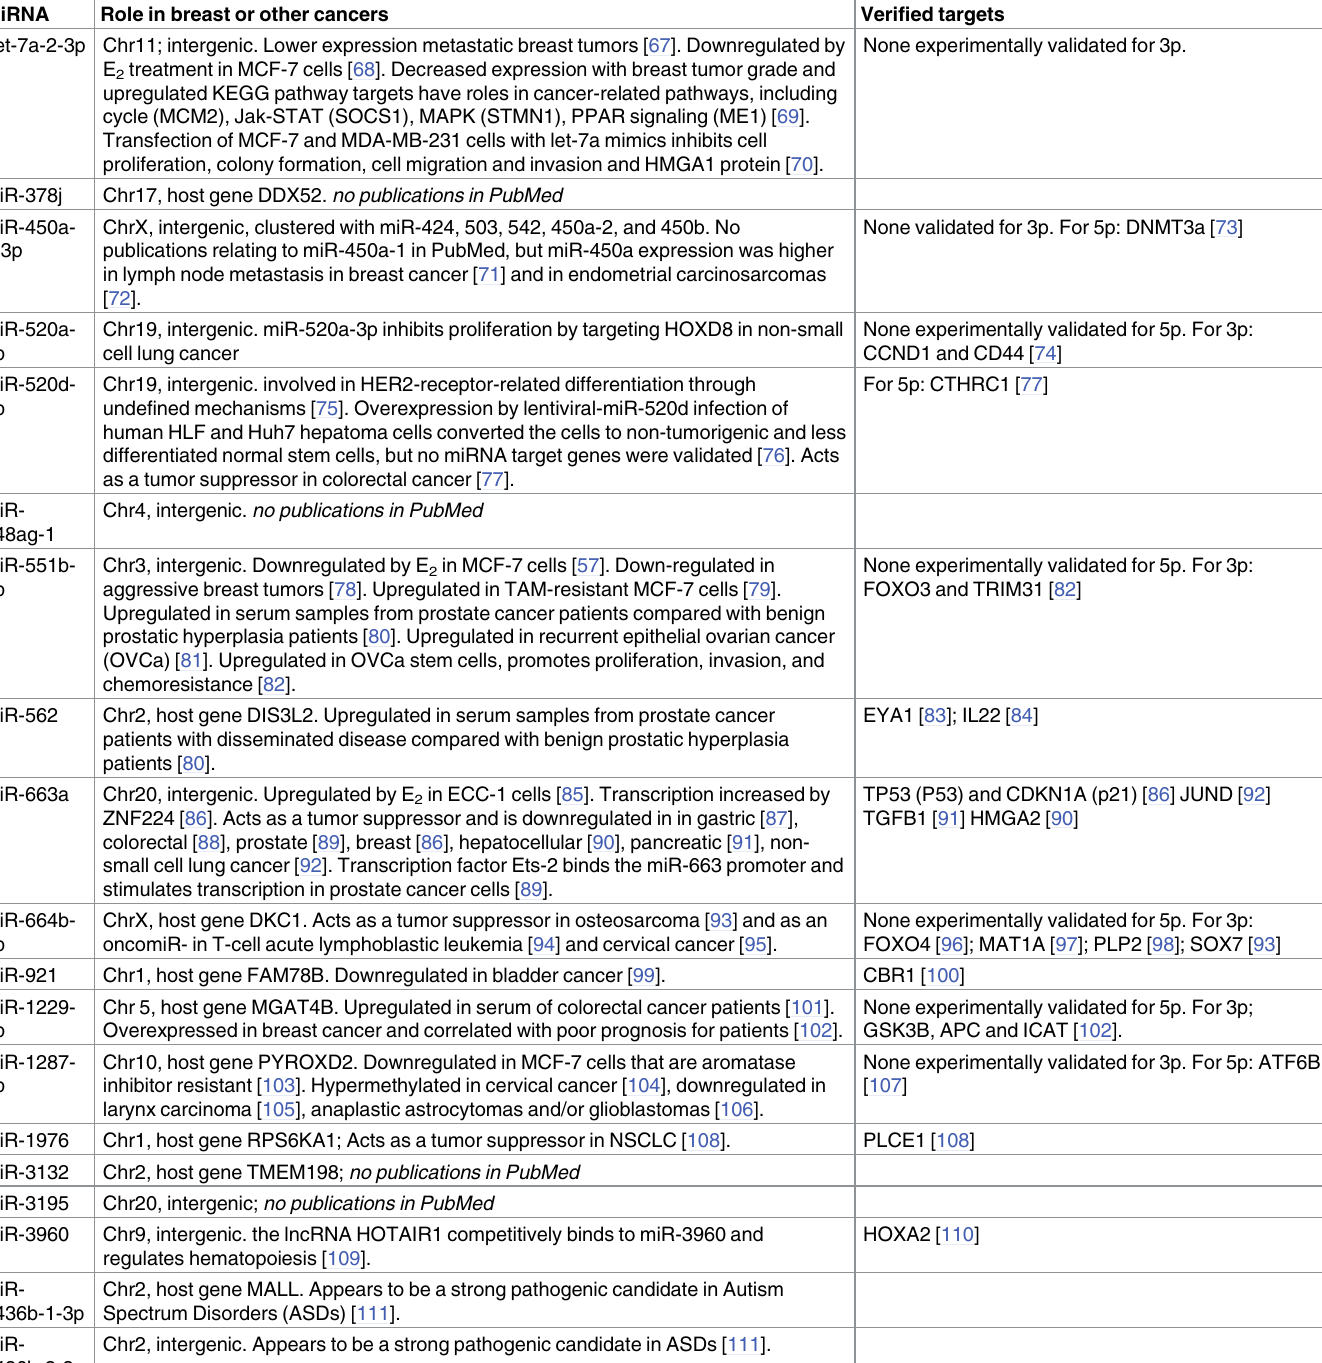
Table 4. miRNAs upregulated by AnAc MCF-7 cells. The genomiclocationof each miRNA was identifiedin miRAD http://bmi.ana.med.uni-muenchen.de/ miriad/ [34]. Verified targets are those experimentally validatedtargets of the indicatedmiRNA as demonstrated by 3’-UTR luciferase reporter assay in